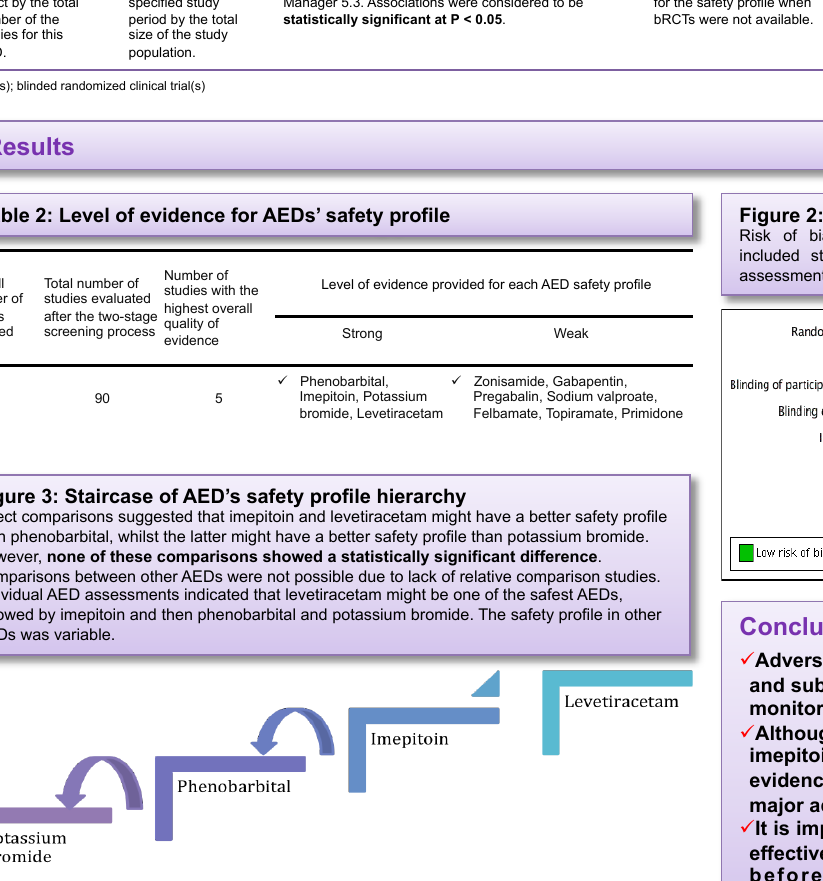
Figure 1: Criteria for evaluation of the overall quality of evidence for each study Blinded randomized clinical trials (bRCTs) with large group sizes, clear inclusion criteria and diagnostic investigations that included clinical signs and thorough test results consistent with the diagnosis of IE, describing outcomes specific for IE and low overall risk of bias were considered to provide the highest available quality of evidence.